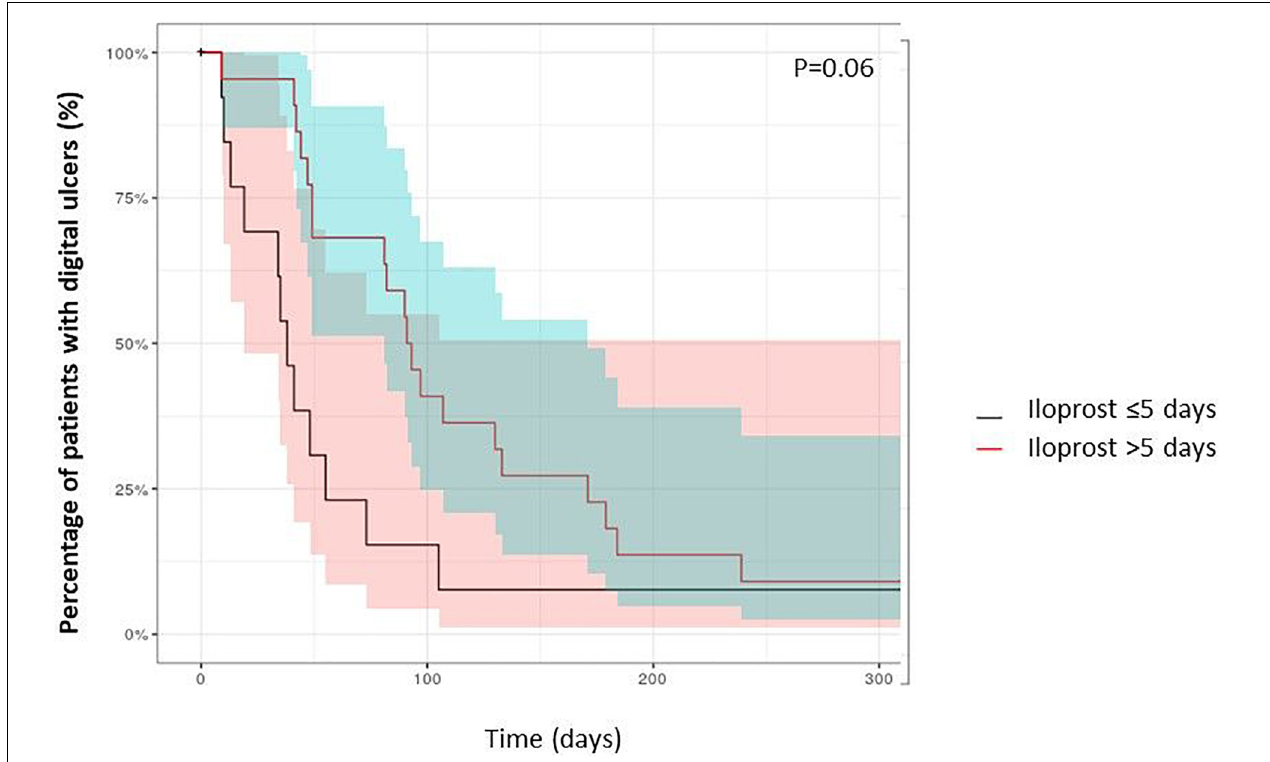
FIGURE 1 | Time to healing of digital ulcers of SSc patients (Kaplan Meyer